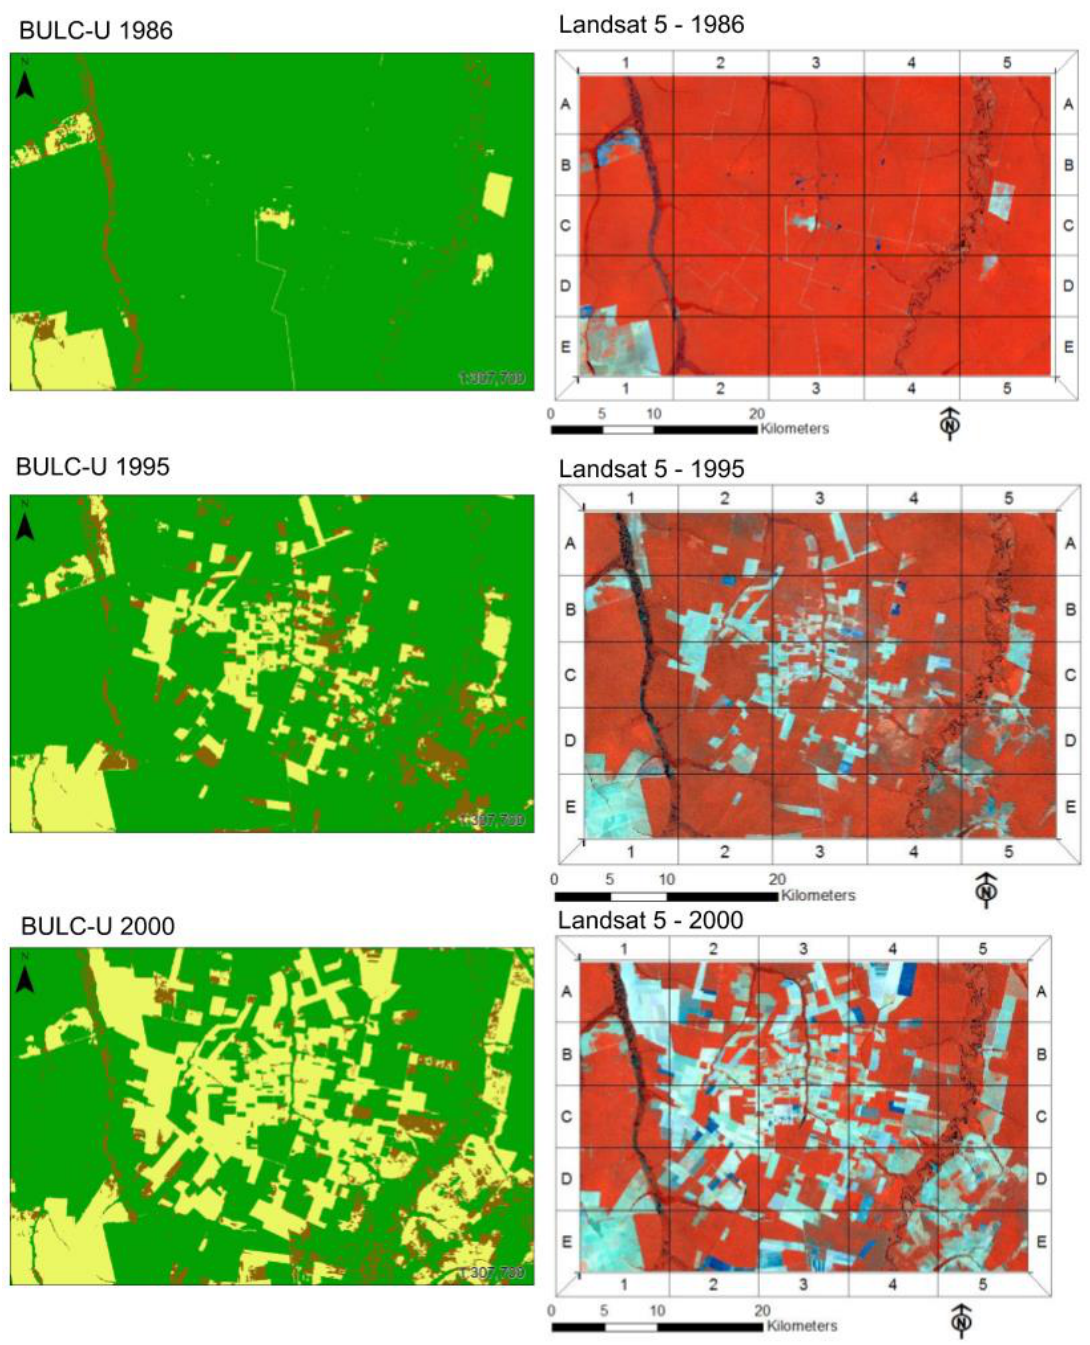
Figure 8. Land-cover maps through time of the town of Querência, located in sector C2 of the study area (see Figures 4 and 5). Top left: BULC-U 1986. Top right: Landsat 5 1986. Middle left: 1995 BULC-U. Middle left: Landsat 5 1995. Bottom left: BULC-U 2000. Bottom right: Landsat 5 2000.